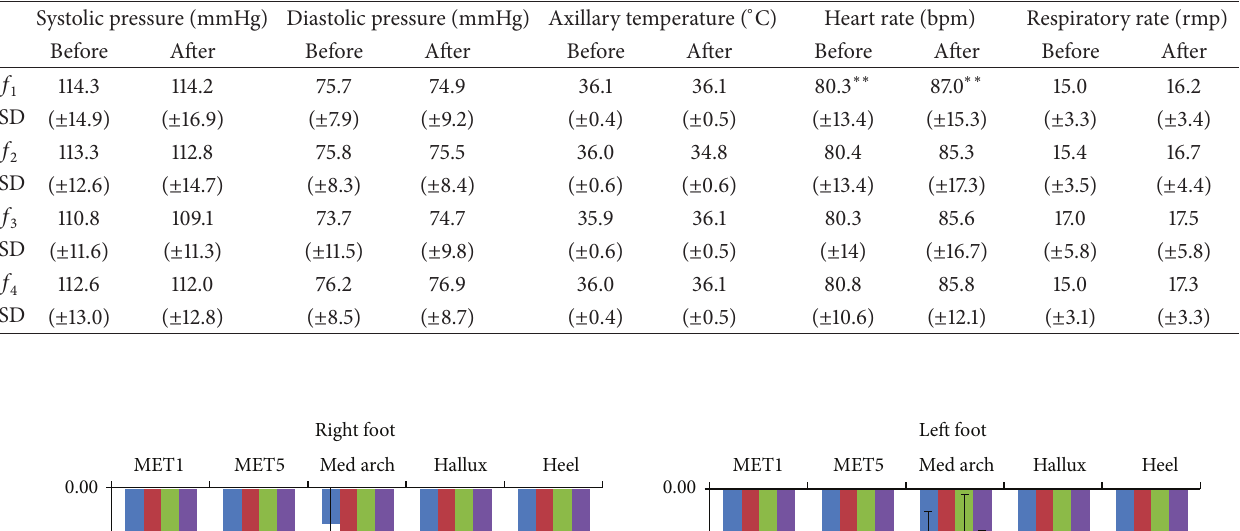
Table 1: Mean and standard deviation ( ± SD) for all 24 subjects before and after 15 minutes of WBV exposure. The values are for physiological measurements such as blood pressure, axillary temperature, heart rate, and respiratory rate, measured at 4 different frequencies of WBV ( 𝑓 1 = 31 , 𝑓 2 = 35 , 𝑓 3 = 40 , and 𝑓 4 = 44 Hz) ( ∗∗ 𝑃 < 0.01 ).